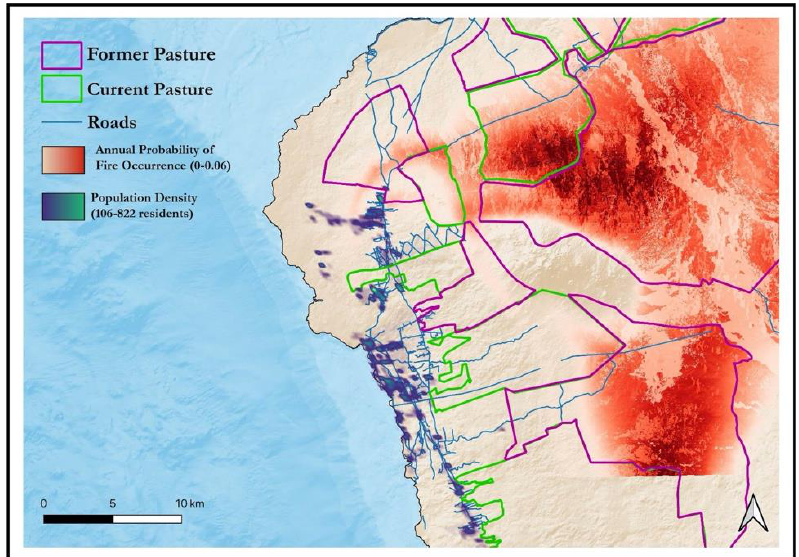
Figure 5. Map depicting fire risk in the Northwest area of Hawai‘i Island. Areas outlined in purple represent former pasture (in 1978), and areas in green represent current pasture (in 2015) [10]. Pop- ulation density shows where people are in relation to high-risk